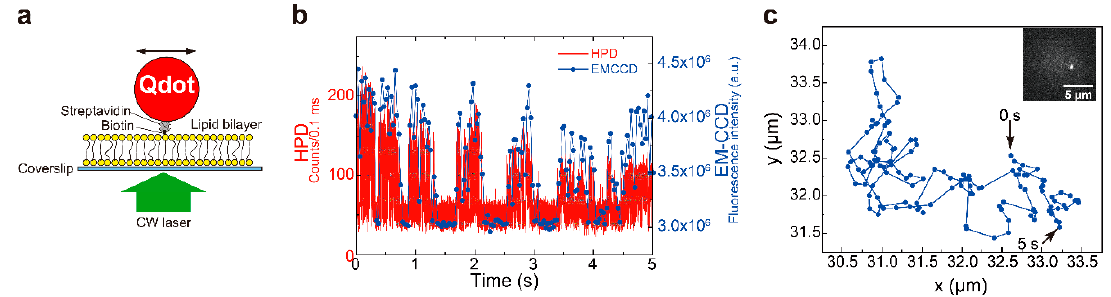
Figure 15. Wide-field sub-millisecond single-molecule fluorescence detection by a cooled HPD [32]: ( a ) Schematic of the observed mobile Qdot. The Qdot (Qdot655 streptavidin conjugate) was attached to biotinylated phosphoethanolamine (PE), 1,2-dioleoyl-sn-glycero-3-phosphoethanolamine-N-(cap biotinyl), via biotin-streptavidin interaction in a 1,2-dioleoyl-sn-glycero-3-phosphocholine (DOPC) lipid bilayer formed on a coverslip. The Qdot was excited by a CW laser (wavelength = 532 nm); ( b ) Time course of a mobile Qdot fluorescence intensity was obtained by an HPD with a time resolution of 0.1 ms (red). The repeated fluorescence-on and –off are caused by blinking. The intensity profile matches the intensity simultaneously obtained by EMCCD (blue) with a time resolution of 31.319 ms; ( c ) Trajectory of the Qdot obtained by EMCCD. The inset is a fluorescence image of the observed mobile Qdot.